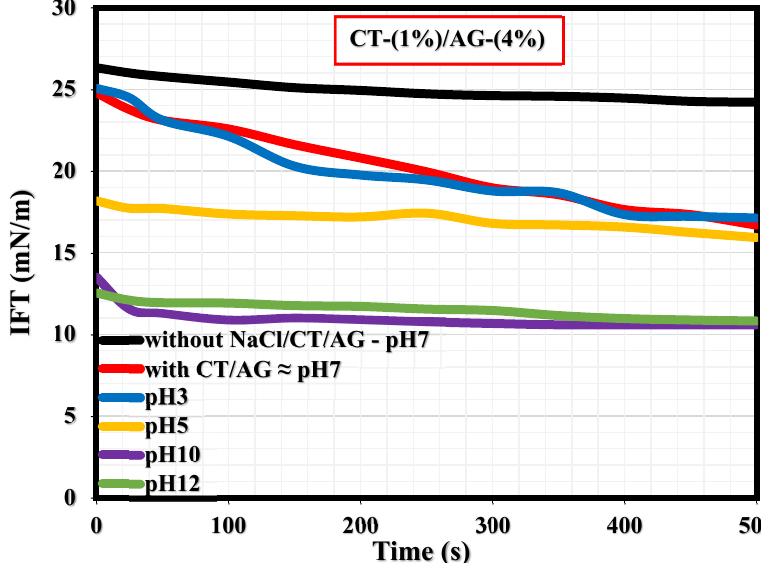
Figure 11. Effects of pH on the dynamic IFT at the diesel/water interface.